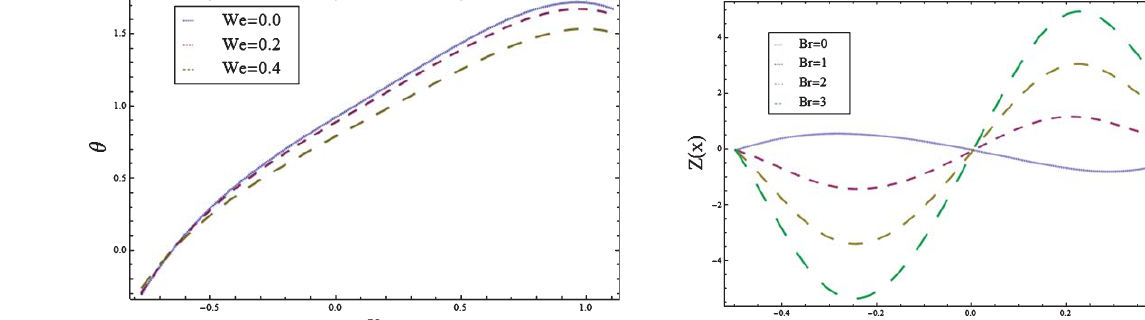
= 1, Bi = 10, x = 0 . 2 and Br = 1. 1 2